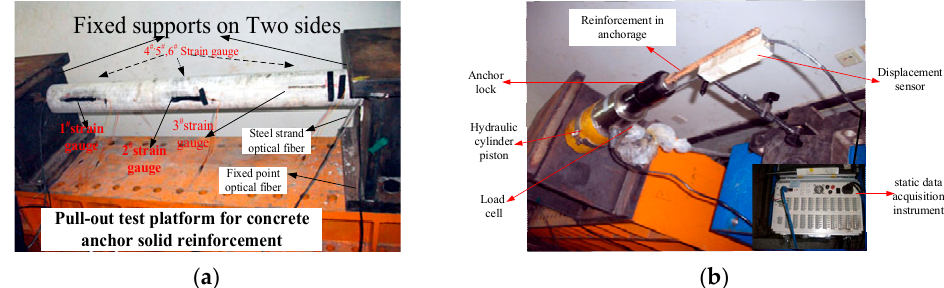
Figure 4. Layout of reinforced concrete pull-out test; ( a ) shows the experiment platform; ( b ) shows the testing system and pull-out system of the experiment.